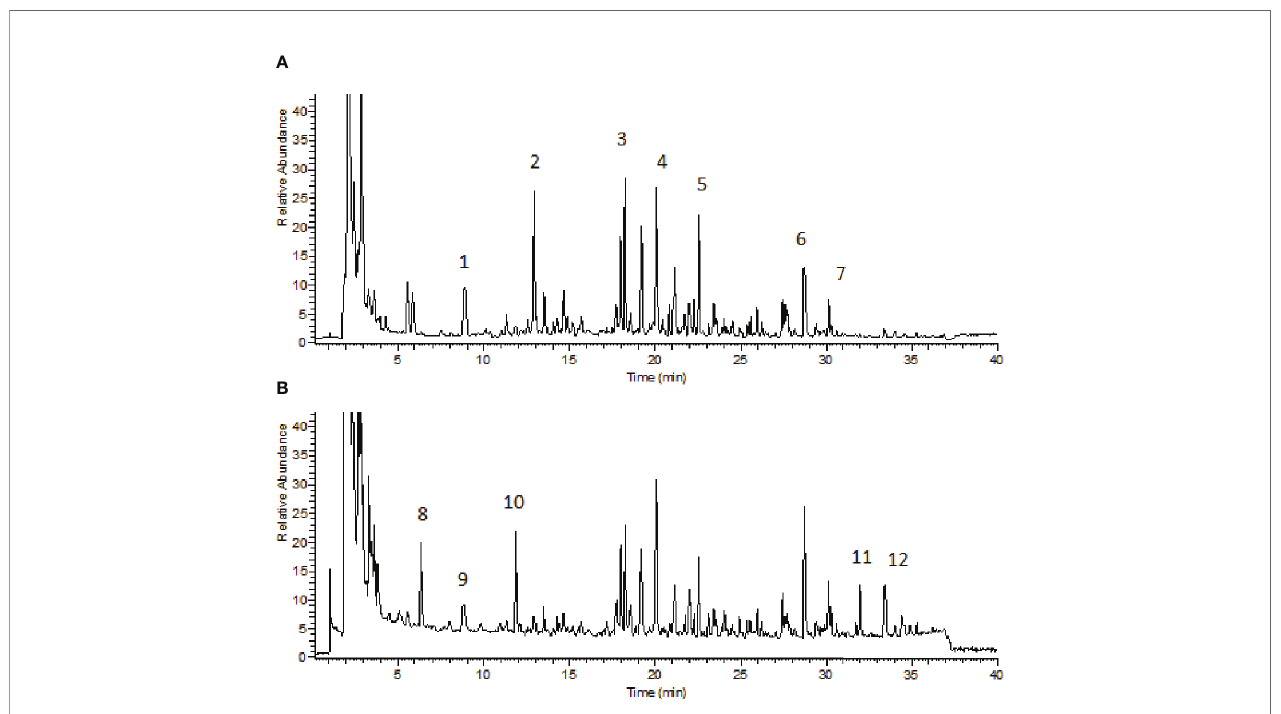
FIGURE 1 | Total ion chromatogram of BZYQD extract in negative-ion mode (A) and positive-ion mode (B) . 1: Piscidic acid; 2: Ferulic acid; 3: Liquiritin; 4: Hesperidin; 5: 2-feruloylpiscidic acid; 6: Glycyrrhizic Acid; 7: Saikosaponin D; 8: Synephrine; 9: Codonopyrrolidium B; 10: Tryptophan; 11: Nobiletin; 12: 3, 5, 6, 7, 8, 3', 4'-heptamethoxy fl